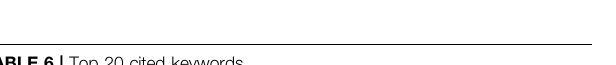
TABLE 6 | Top 20 cited keywords.